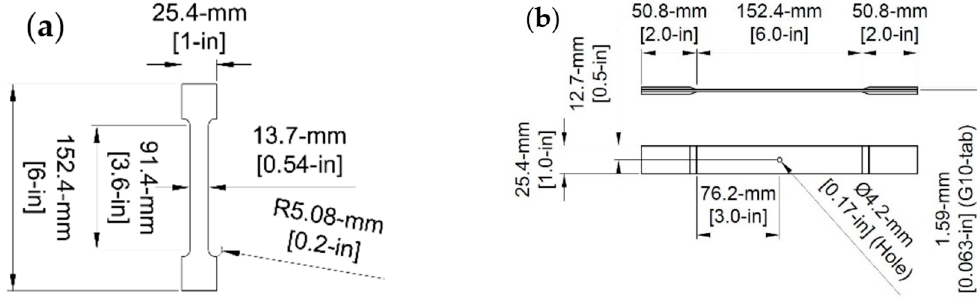
Figure 1. ( a ) Stainless steel dog ‐ bone shape; and ( b ) Composite coupon dimensions with end tabs.